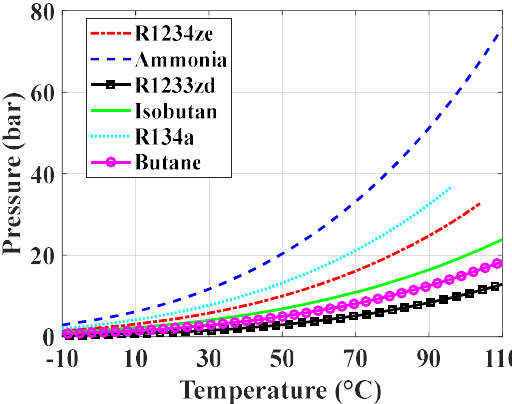
Figure 3. Saturation curves in the pressure-temperature diagram for the selected working fluids.